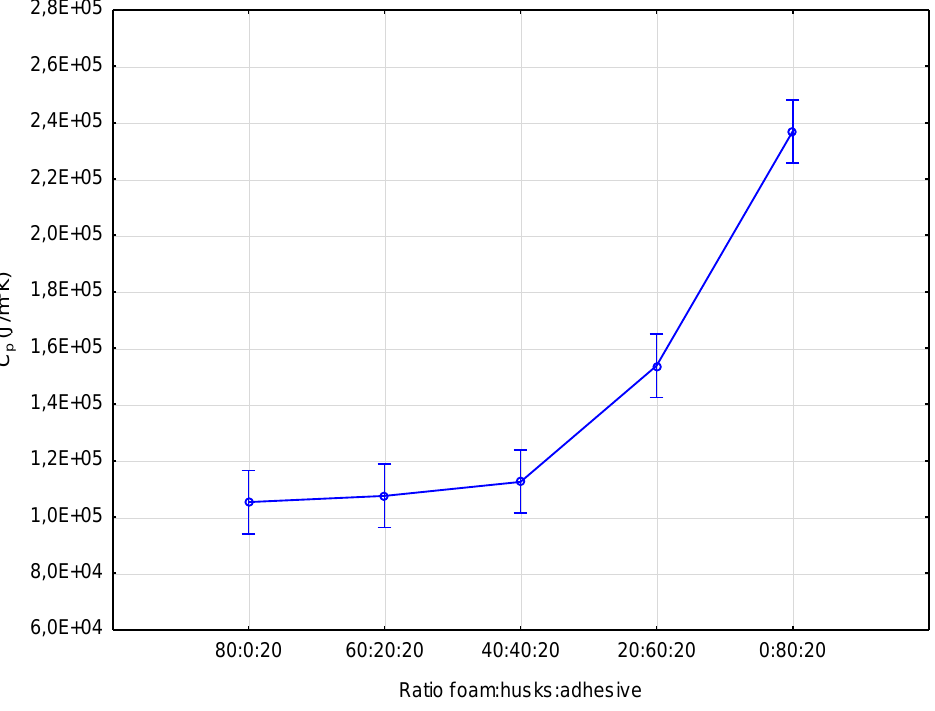
Figure 3. Impact of the composition of the panel on volumetric heat capacity. Table 5. p-values of Tukey post-hoc test: statistical significance of the differences in the graph in Figure 3.